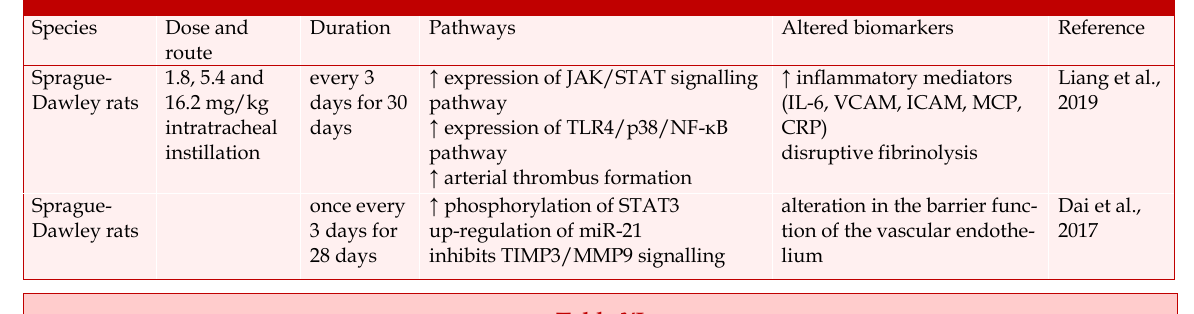
Monosodium glutamate-induced vascular endothelial